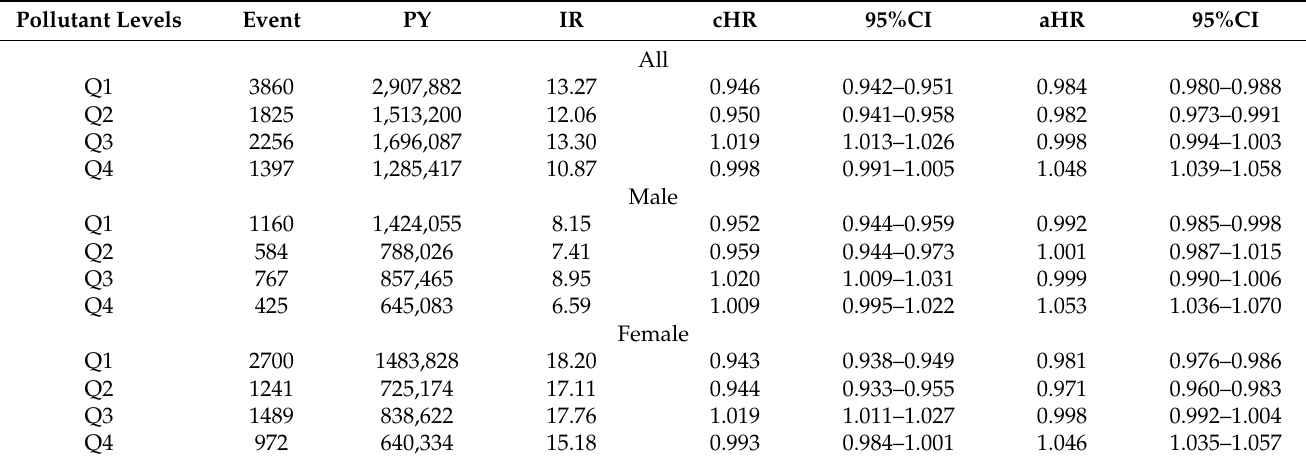
Table 3. Comparison of RA incidence and related HR differences among participants exposed to average annual concentrations of